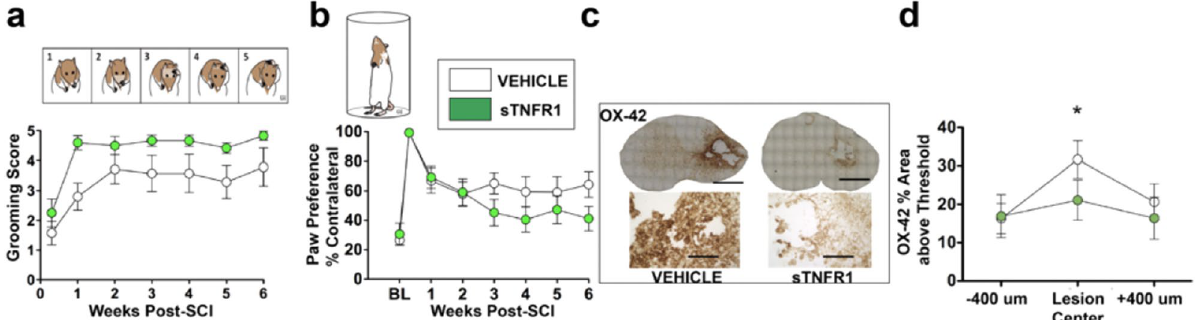
Figure 4. Acute sTNFR1 treatment improves behavioral recovery and mitigates chronic neuroinflammation. Tests of forelimb recovery following unilateral cervical contusion were assessed for 6 weeks